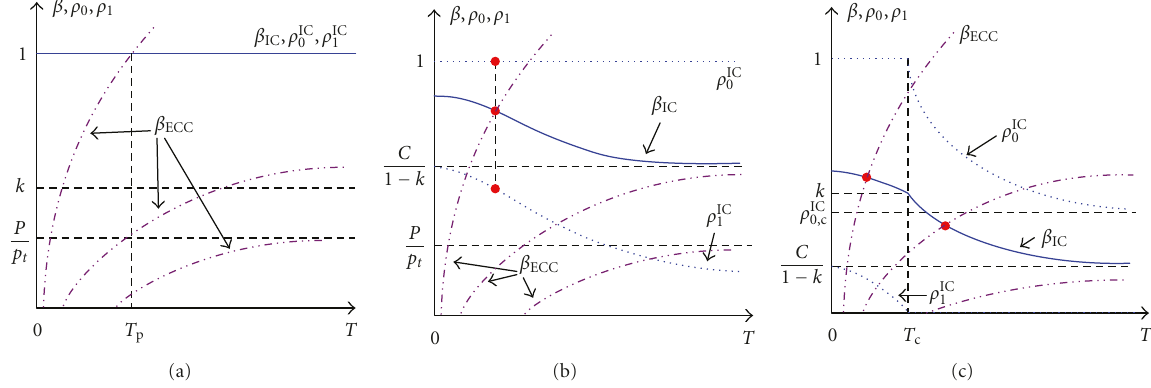
Figure 3: Illustration of the relationship of IC and ECC under access policy π 2 .β ECC is the maximal β under ECC. β IC is the maximal β under IC and ρ IC 0 , ρ IC 1 are its corresponding transmission allocation.